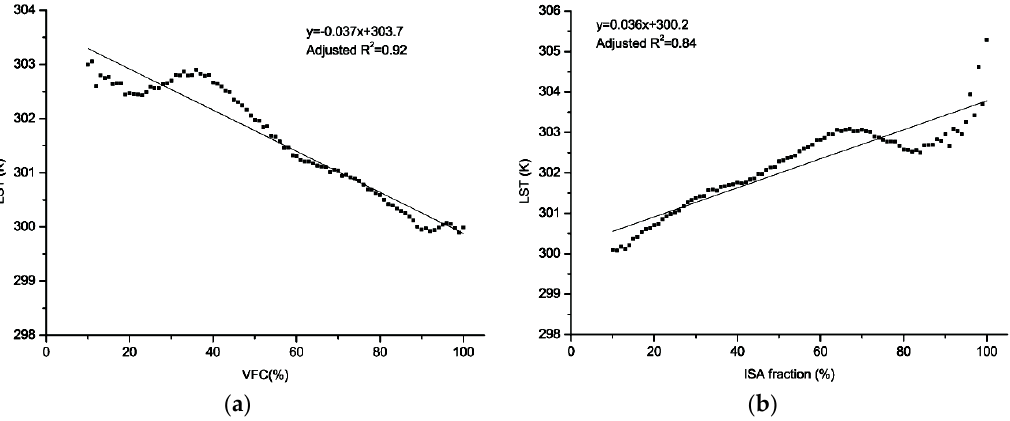
Figure 7. Scatterplots of ( a ) mean LST versus vegetation coverage and ( b ) mean LST versus percentage of ISA.